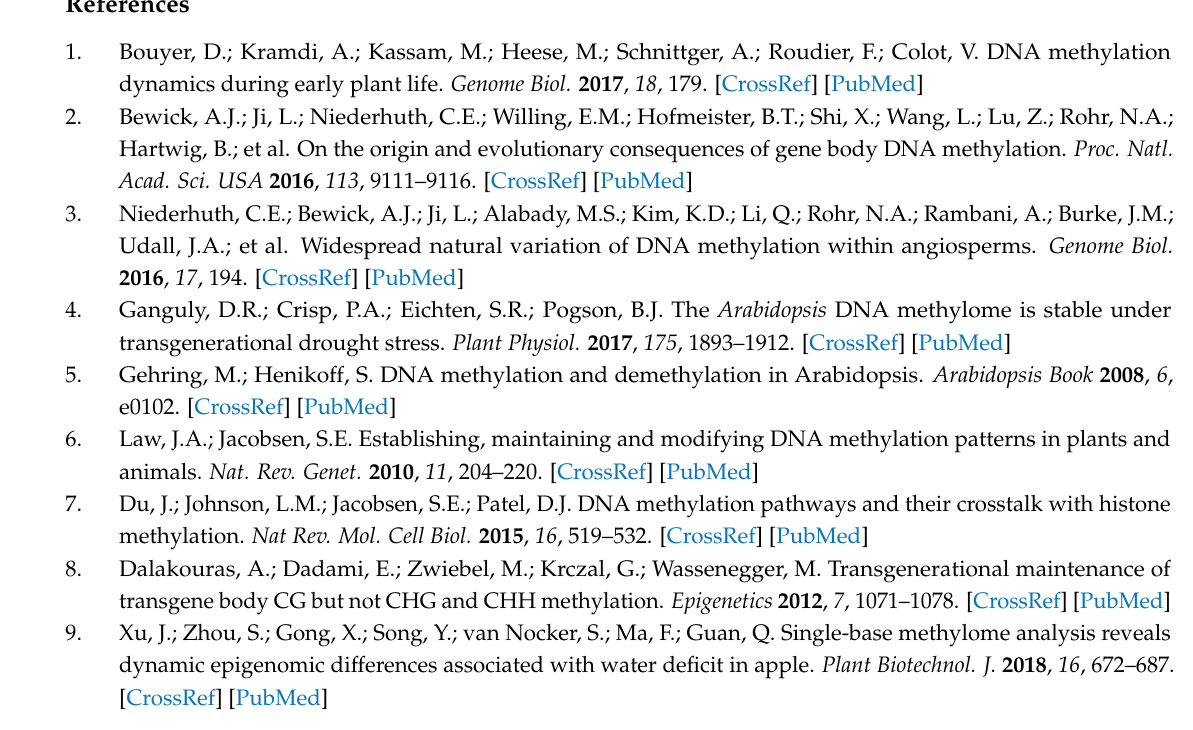
Figure S1: Length distributions of the DMRs. Control vs. Sense (J01 vs. J02), Figure S2: Length distributions of the DMRs. Control vs Antiense (J01 vs. J03), Figure S3: Length distributions of the DMRs. Sense vs. Antiense (J02 vs. J03), Table S1: The sample sequencing data evaluation statistics of the three samples, Table S2: The comparison results statistics of the three samples, Table S3: The detection of 5mC statistics of the three samples, Table S4: The GO and KEGG analysis results of DMRSs; Table S5: The DMRs and DEGs analysis results; Table S6: The DMRs and DEGs involved in ethylene pathway; Table S7: The relations between DNA methylation and miRNAs analysis